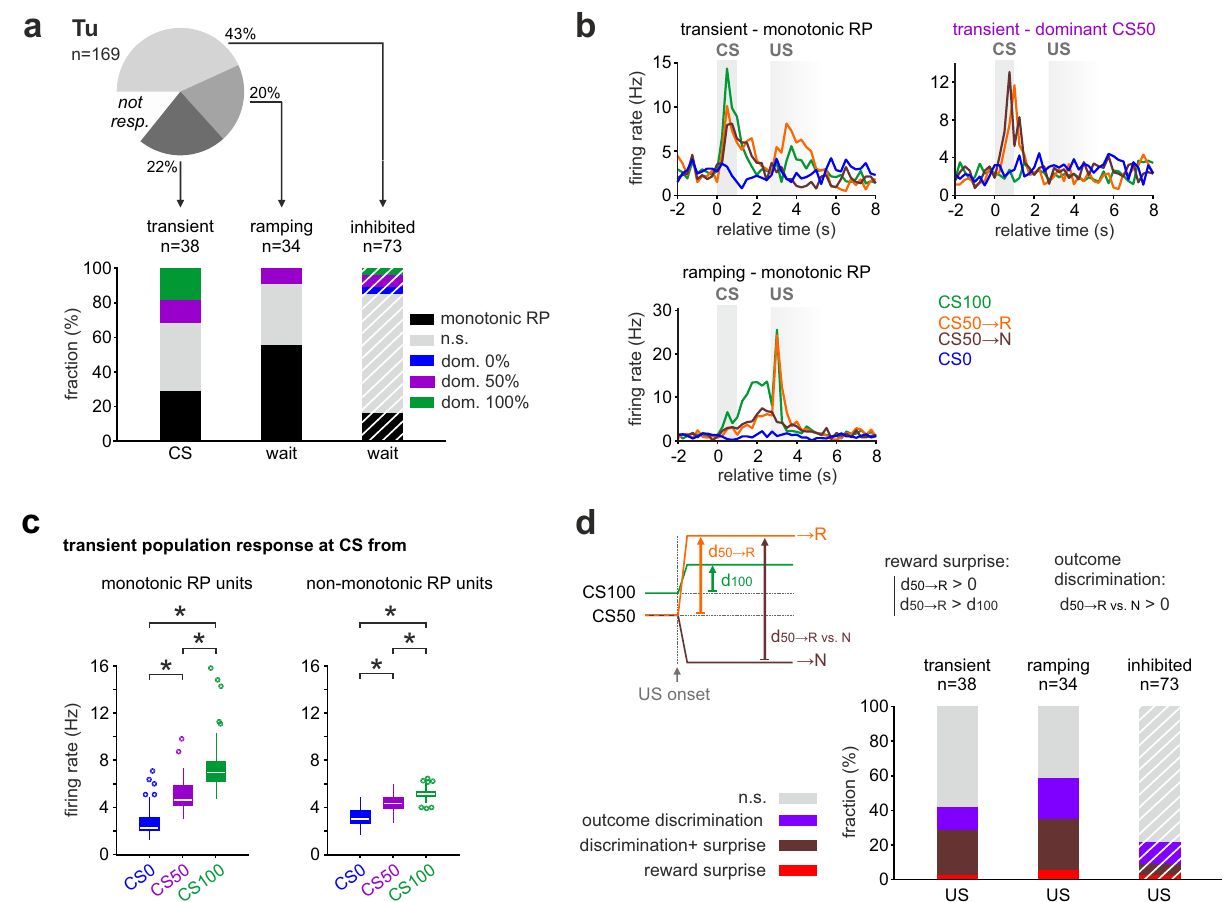
Fig. 8 Transient and ramping units differently encode monotonic RP in Tu. a (Top) Percentage of Tu units in the three major response clusters from Fig. 7k – m. (Bottom) Percentage of units in each cluster coding monotonic RP or showing a dominant response to one of the CS (test window indicated below each bar, see Supplementary Fig. 9a for test on complementary windows). Note that more than half of the units in the ramping cluster displayed monotonic RP during wait while only a quarter from the transient cluster did so at CS. RP and CS coding were tested via two-tailed t test with signi fi cance threshold at P < 0.05. Dashed lines indicate that the task-inhibited cluster was tested for reduction in fi ring rate (see “ Methods ” ). b Example units illustrating (upper left) monotonic RP or (upper right) dominant CS50 activation at CS in two units from the transient cluster, and (lower left) monotonic RP during wait of a unit from the ramping cluster (displayed average fi ring rate). c Median fi ring rate at CS of the units in the transient cluster that encoded individually positive monotonic RP (left; n = 11 units) or non-monotonic (right; n = 26 units) responses (one-way ANOVA with Tukey post hoc comparisons). Units not individually coding monotonic RP still displayed a robust monotonic RP as a population. Thus, the transient cluster displayed monotonic RP by distributed coding. For ramping clusters, see Supplementary Fig. 9b. The bounds of the boxplot represent 25th to 75th percentiles. The lower and upper whiskers represent minimum and maximum values without outliers; outliers indicated by circles. * indicates P < 0.05 (see Supplementary Table 1 for P values and test details). Source data are provided as a Source Data fi le. d Scheme illustrating reward surprise and outcome discrimination (top). Units were categorized as coding for reward surprise if during CS50 rewarded trials their increase in fi ring rate from before to after US (d 50 → R ) was positive and bigger than that in CS100 trials (d 100 ). Units were categorized as coding for outcome discrimination if the fi ring rate at US was higher for rewarded than for unrewarded trials (d 50 → R vs. N > 0). Tests were performed via two-tailed t test with a signi fi cance threshold at P < 0.05. (Bottom) Fraction of units from the three Tu clusters with reward surprise or outcome discrimination or both. Dashed lines indicate that the task-inhibited cluster was tested for the reduction in fi ring rate (see “ Methods ” ). In the fi gure: n indicates the number of